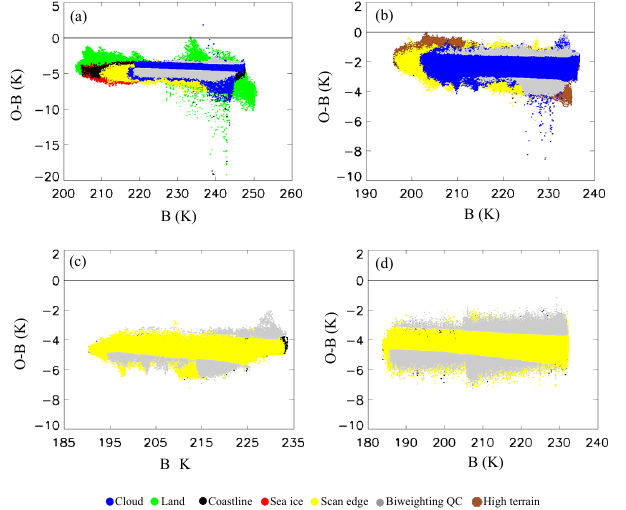
Figure 8. Scatter plots of the differences of the brightness temper- ature between observations and model simulations for the data of MWTS-2 (a) channel 5, (b) channel 6, (c) channel 7, and (8) chan- nel 8 that have passed quality control during 1–5 July